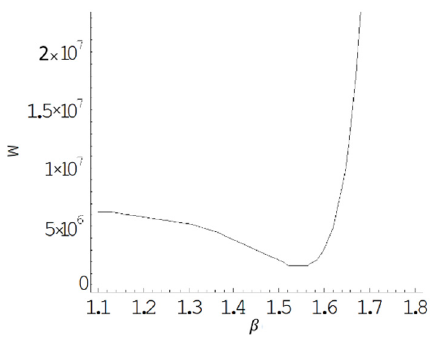
Figure 11. Total cost versus parameter β .